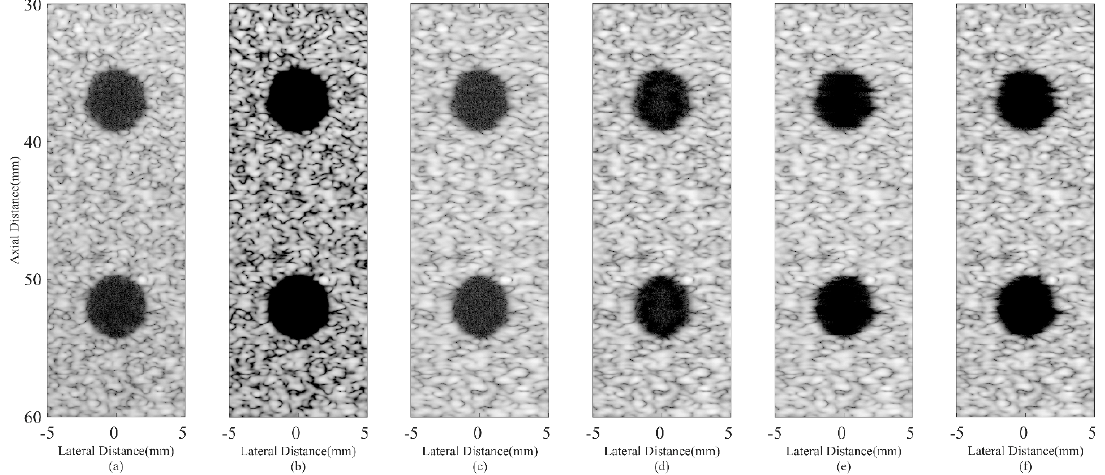
Figure 4. Simulated anechoic cysts using different beamformers: ( a ) DAS, ( b ) CF, ( c ) JTR-MV, ( d ) JTR-MV GCF, ( e ) JTR-ESBMV, ( f ) JTR-ESBMV GCF. All images are shown with a dynamic range of 60 dB. Table 3. CR and CNR for simulated anechoic cysts.